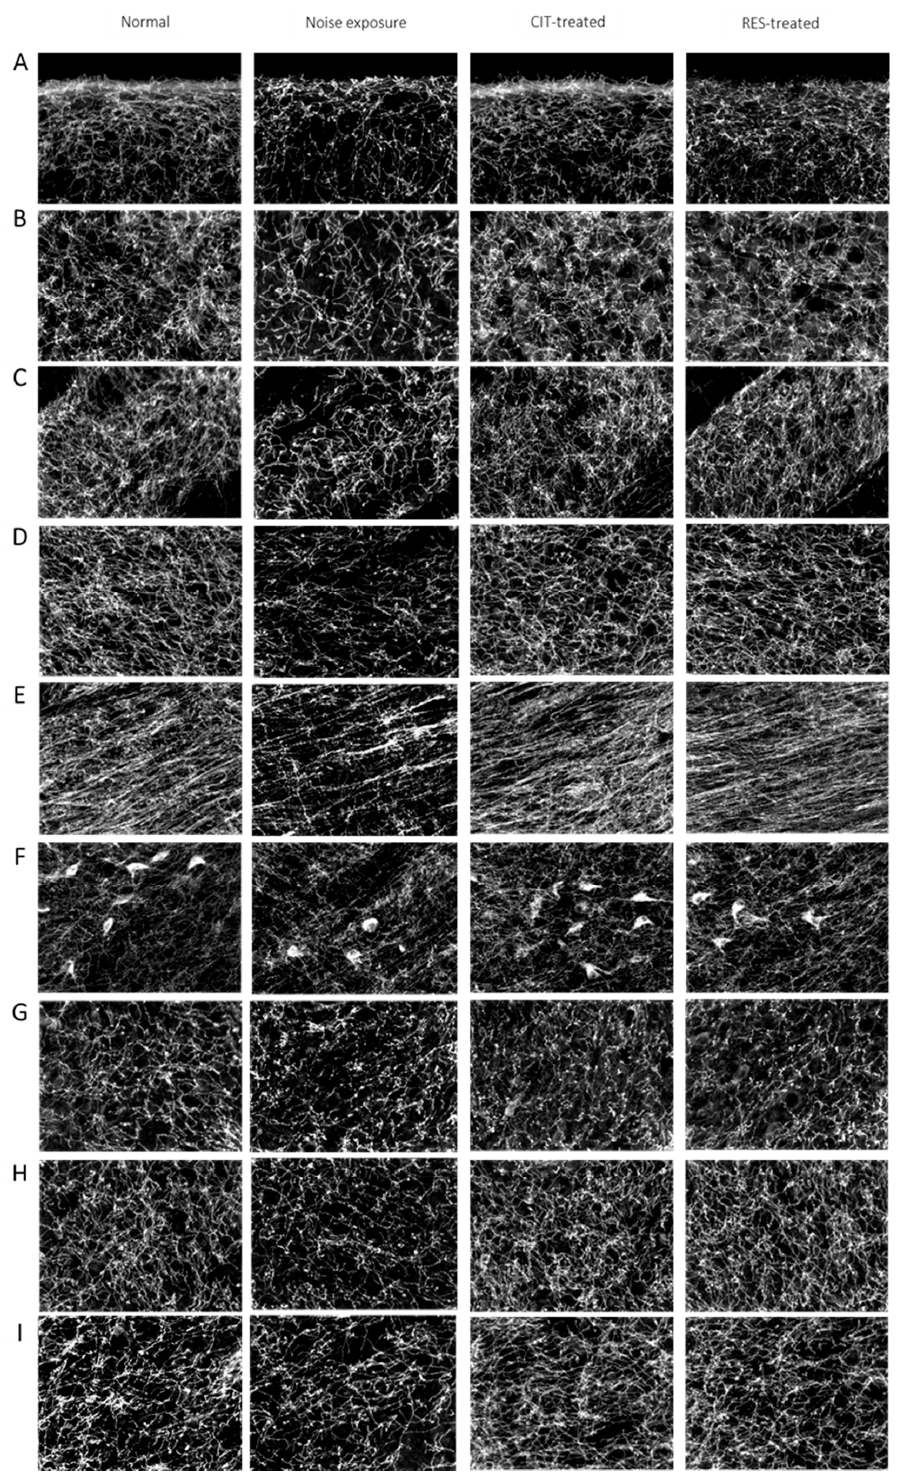
Figure 4. Photomicrographs of serotonin transporters following immunohistochemistry staining in various brain regions of the control group, the NE group, the CIT-treated group, and the RES-treated group 4 days after noise exposure are displayed. The serotonergic fiber densities in various brain regions were lower in the NE group. ( A ) frontal cortex; ( B ) auditory cortex; ( C ) striatum; ( D ) thalamus; ( E ) hypothalamus; ( F ) raphe nucleus; ( G ) cochlear nucleus; ( H ) inferior colliculus; and ( I ) hippocampus. (CIT: citalopram, RES: resveratrol, NE: noise